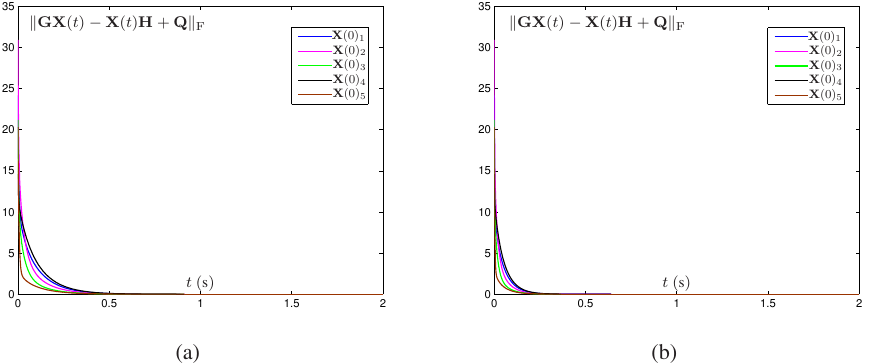
Figure 3. Convergence behaviors of residual error (cid:107) GX ( t ) − X ( t ) H + Q (cid:107) F of GNN models (6) and (9) starting from 5 randomly created initial values (i.e., X ( 0 ) 1 ∼ X ( 0 ) 5 ) for Sylvester equation. ( a ) By GNN model (6). ( b ) By GNN model